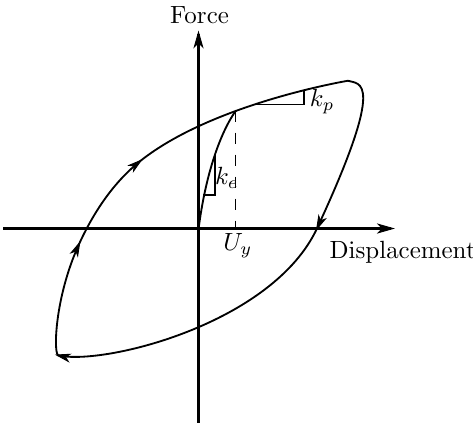
Figure 3. The force-displacement characteristics of the bearing.